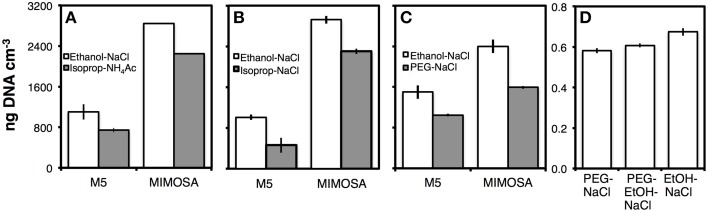
Comparisons of DNA yields by different precipitation methods in relation to Ethanol-NaCl precipitation. (A) Isopropanol-ammonium acetate precipitation; (B) isopropanol-NaCl precipitation; (C) PEG 6000-NaCl precipitation; (D) PEG 8000-NaCl and PEG-EtOH-NaCl precipitation. As a co-precipitant, we added LPA to a concentration of 20 μg mL−1 of extract to all samples shown in (A–D). LPA and salt solutions were homogenized with extracts prior to adding alcohol or PEG solution. This ensured that nucleic acids in solution were exposed to LPA and added salt. Without this prior homogenization step, LPA was immediately precipitated without going into solution. Due to light sensitivity of LPA, all precipitations were for 2 h in the dark. (A,B) were performed at −20°C (C,D) at room temperature. Error bars in (A-C) indicate standard deviations of tests that were run in triplicate, error bars in (D) indicate data ranges of tests that were run in duplicate.